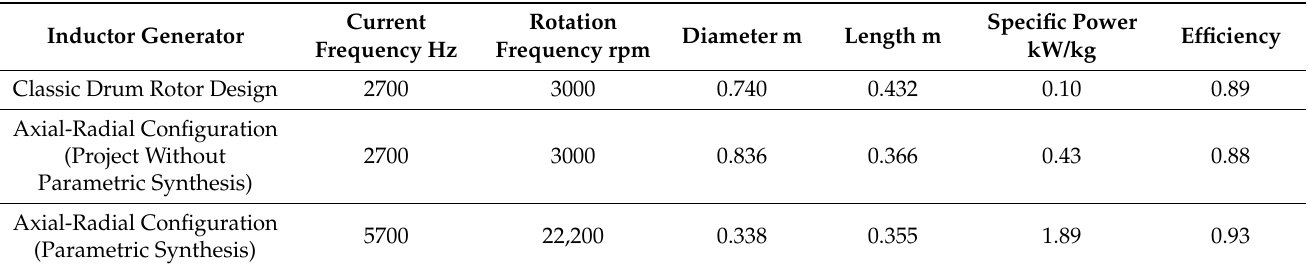
Table 3. Comparative characteristics of inductor